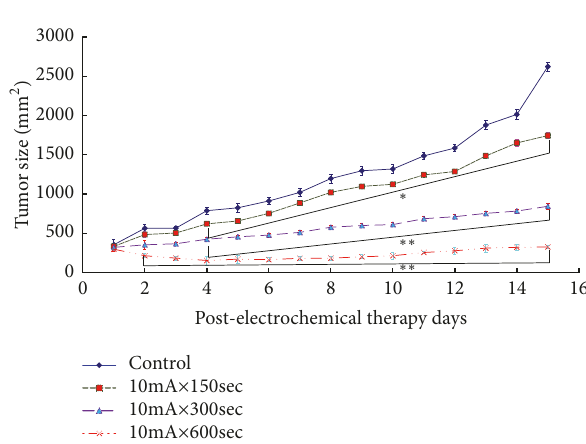
Figure 5: Changes of the tumor volume after SCC-7 inocula- tion in the groups of control, 10mA × 150sec, 10mA × 300sec, and 10mA × 600sec ( ∗ p < 0.05 , ∗∗ p < 0.01 ). The results represent ± S.D. from 8 to 10 mice.